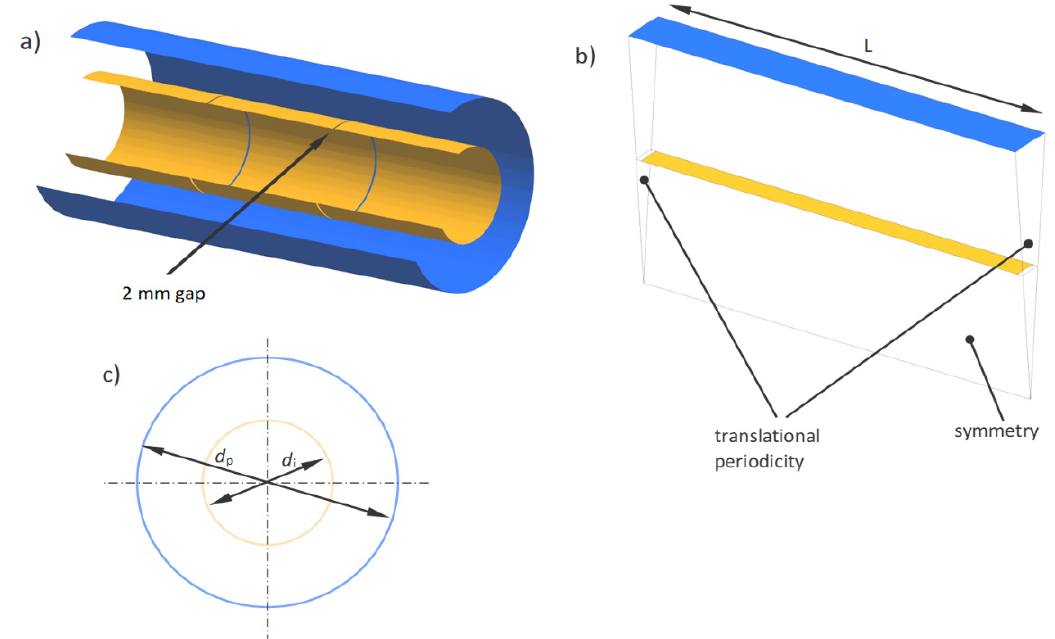
Figure 2. Repeatable insert segment: ( a ) 3D view of the pipe section with insert, ( b ) computational domain, ( c ) channel cross-section diagram.